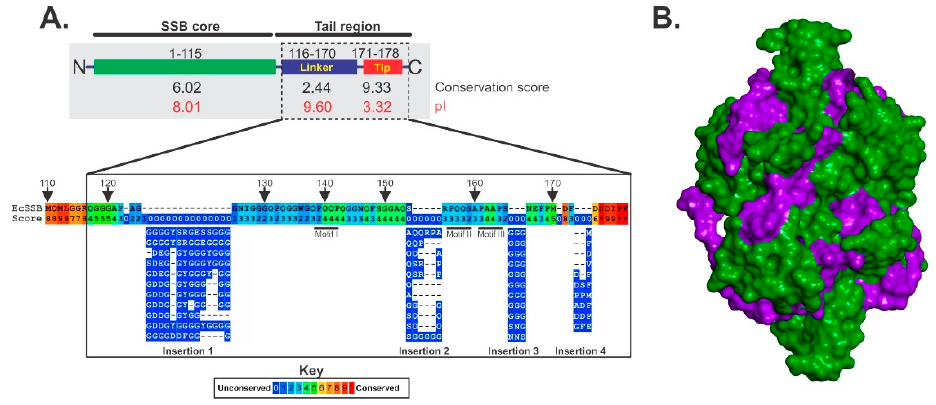
Figure 2. Organization of the SSB protein. ( A ), Schematic of SSB divided into the core and tail regions by proteolytic cleavage. The conservation scores for each region were calculated from alignments using Praline [61]. The pI of each region is shown in red and was calculated using the ProtParam tool of Expasy [62]. The pI of the intact protein is 5.44. ( B ), The SSB tetramer is intimately associated with ssDNA. The image was generated using PDB file 1EYG [58]. The DNA is colored purple and the tetramer, is colored green. Both protein and DNA are represented as Connolly surfaces.